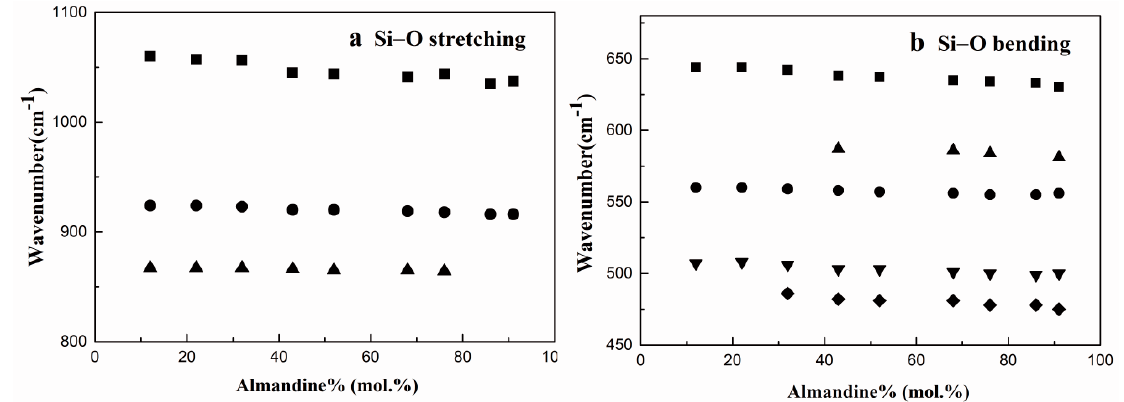
Figure 10. Composition dependence of frequencies of Raman modes corresponding to internal motions of SiO 4 -tetrahedra: ( a ) Si–O stretching and ( b ) Si–O bending.